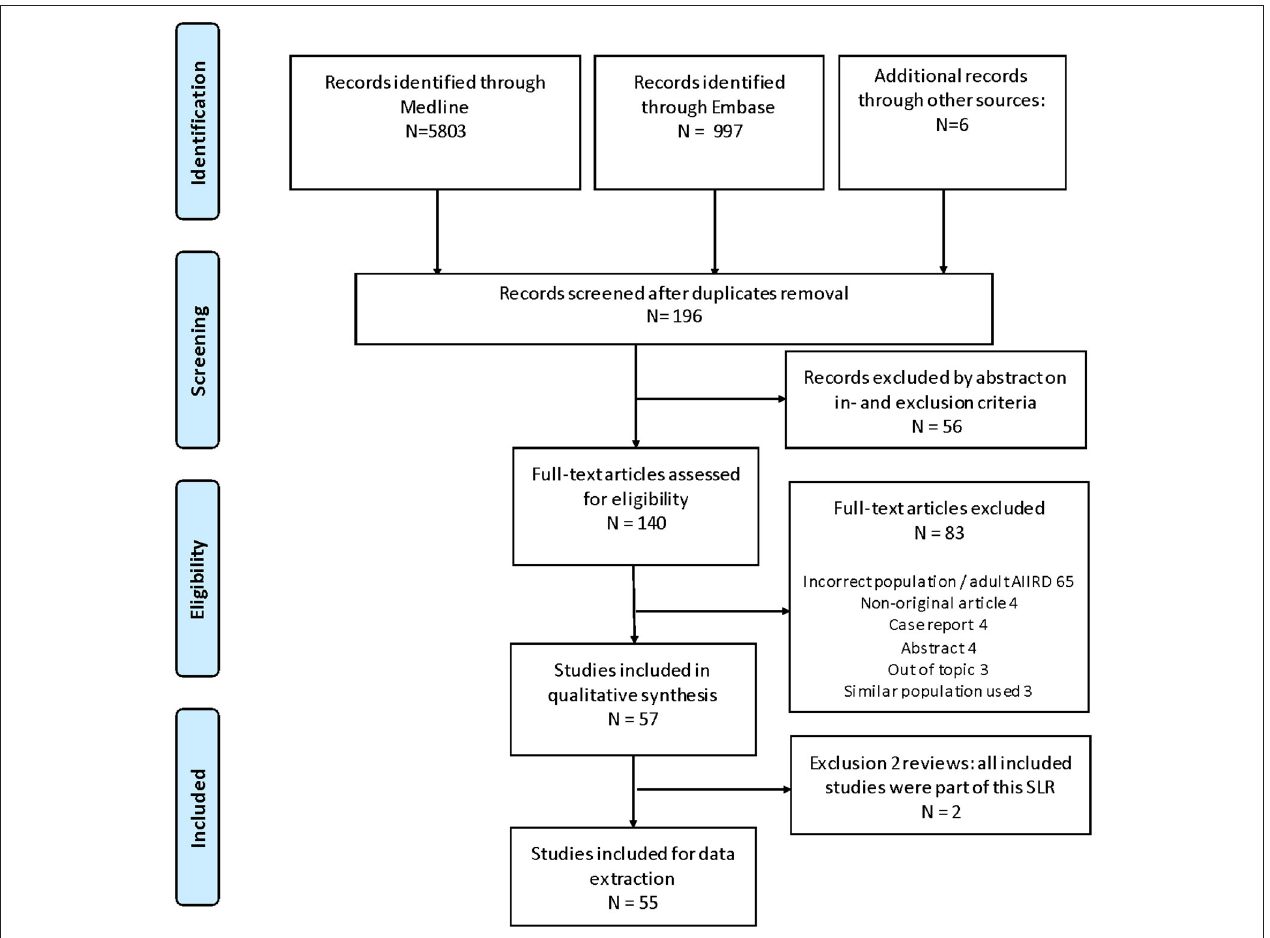
FIGURE 1 | Prisma flow chart of SLR Nov 2011–July